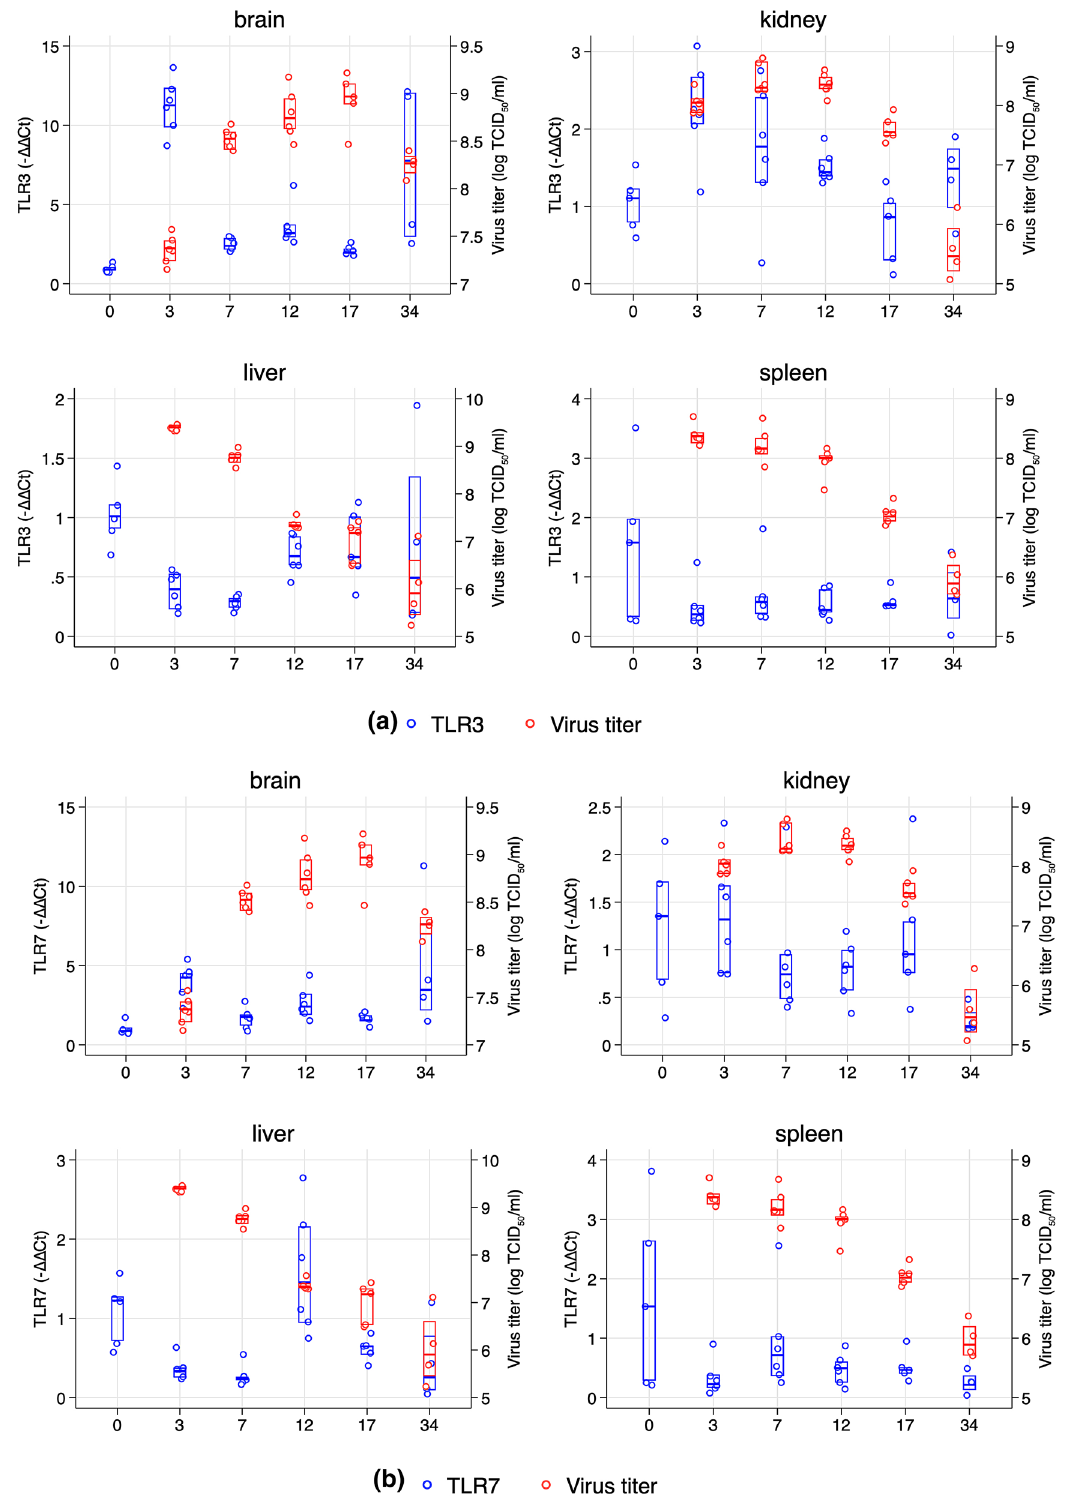
Figure 4. ( a, b ) TLR3 ( a ) and TLR7 ( b ) expression in the different organs over the course of infection plotted against viral titers in corresponding organs. X-axis shows days post challenge while the y-axis shows relative gene expression (2 ddCt -left axis) and virus titer (log TCID 50 , right axis). Median and 25/75% percentile is shown for TLR3/7 and virus